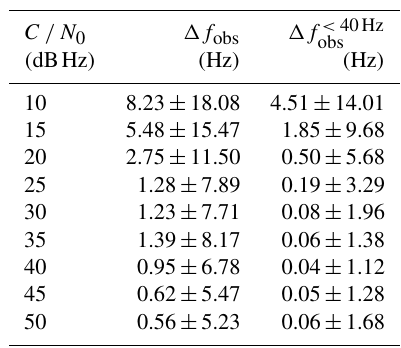
Figure 13. Same as Fig. 12, however, showing the corresponding results from O/L channel B.